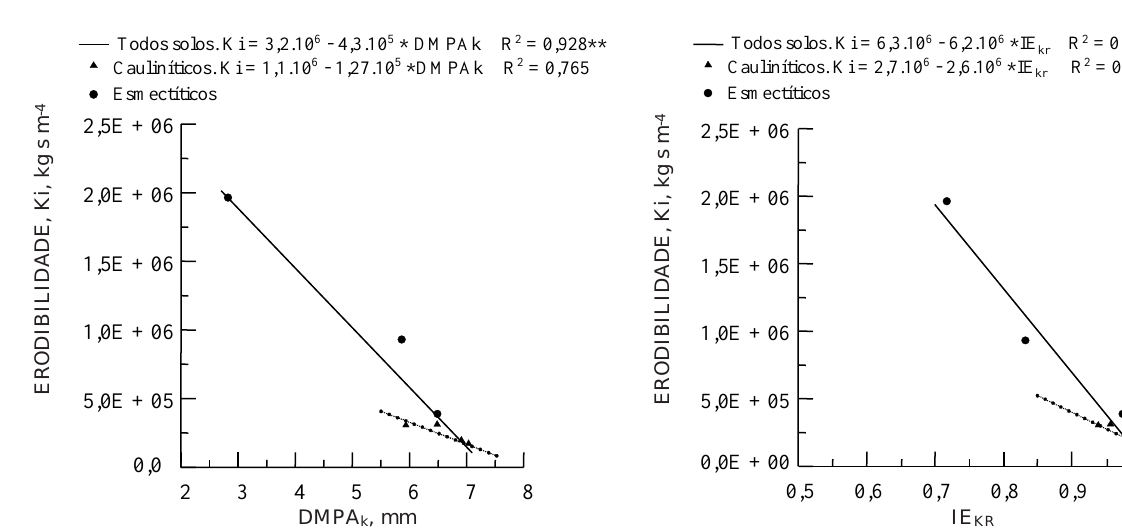
Figura 5. Relação entre a erodibilidade em entressulcos e índice de estabilidade de ) Kemper & Rosenau (1986) (IE ) em amostras K KR de solos do Rio Grande do Sul. A reta (pontilhada) indica o ajuste para os solos